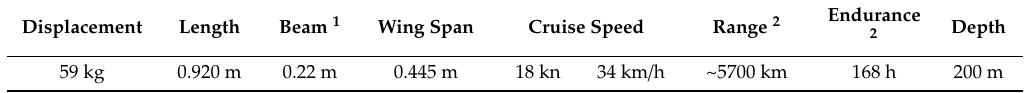
Table 1. AUV: General characteristics and performances (estimated).